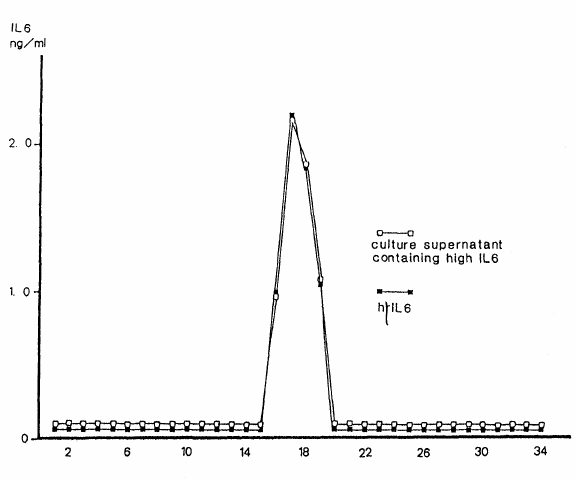
FIG. 2. Elution profile of authentic human recombinant IL-6 (.) and immunoreactive IL-6 produced by human peripheral blood mononuclear cells (VI) on Sephadex G-50.